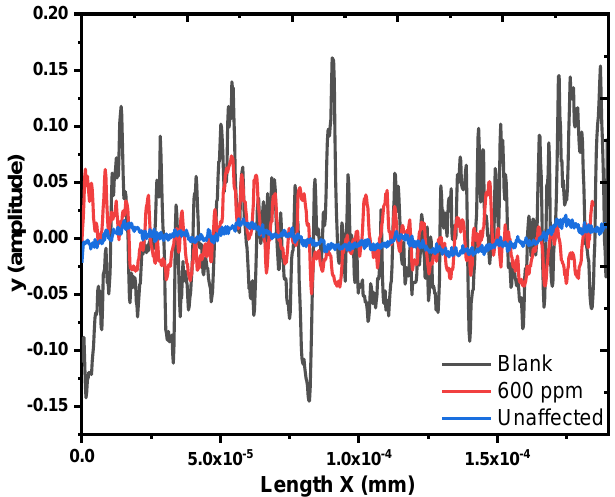
Figure 13. Average roughness plot of mild steel coupons immersed in the blank (black), 600 ppm PBSLP (red) solution, and ground coupon with 1200 grit paper (blue—unaffected).